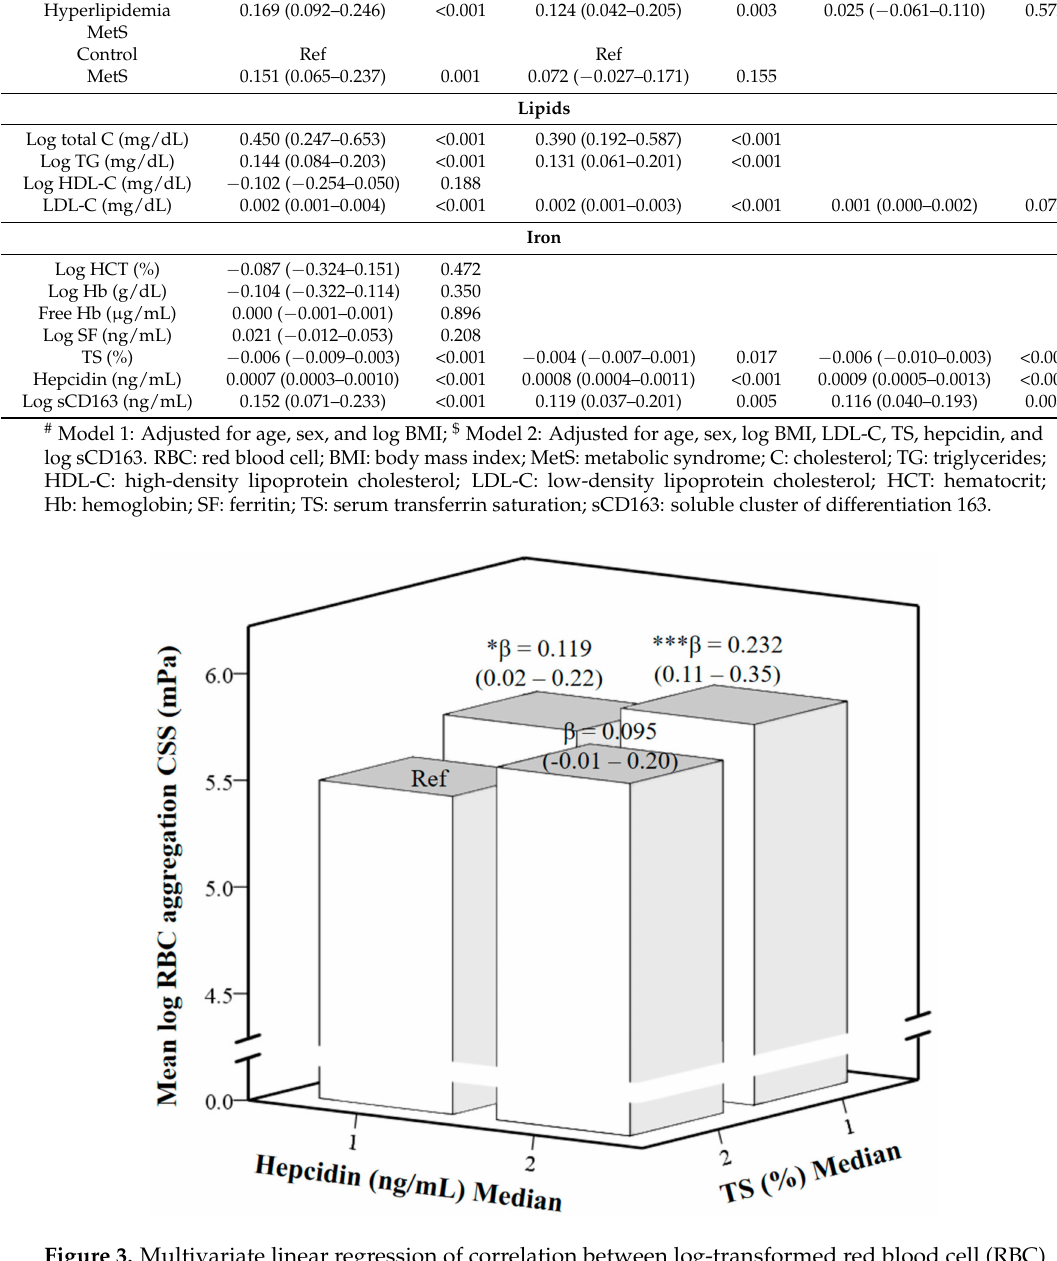
Figure 3. Multivariate linear regression of correlation between log-transformed red blood cell (RBC) aggregation critical shear stress (CSS), medians of hepcidin and transferrin saturation (%TS) levels adjusted by age, sex, and log-transformed body mass index (BMI); β , unstandardized coefficients. * p ≤ 0.05, *** p ≤